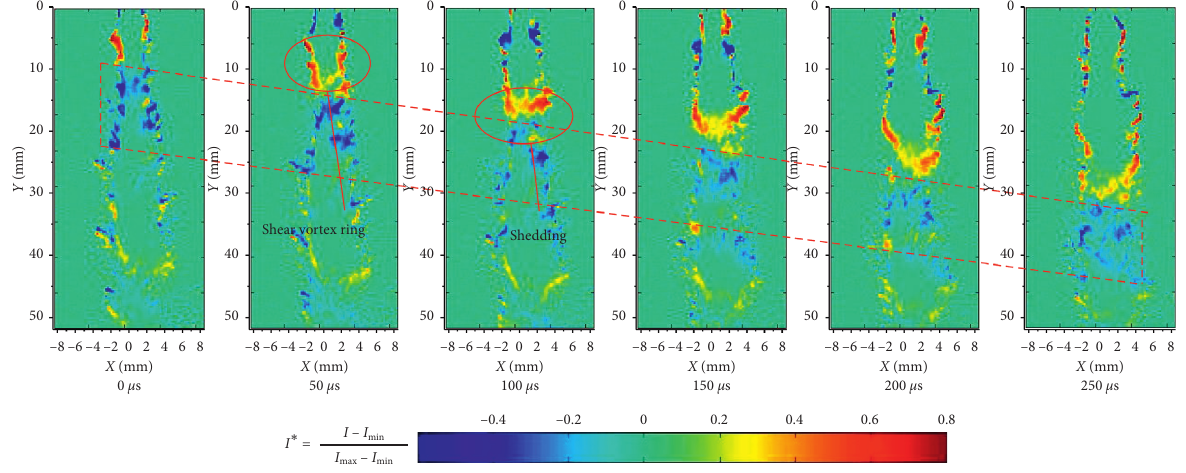
Figure 7: Image treated with the frame difference